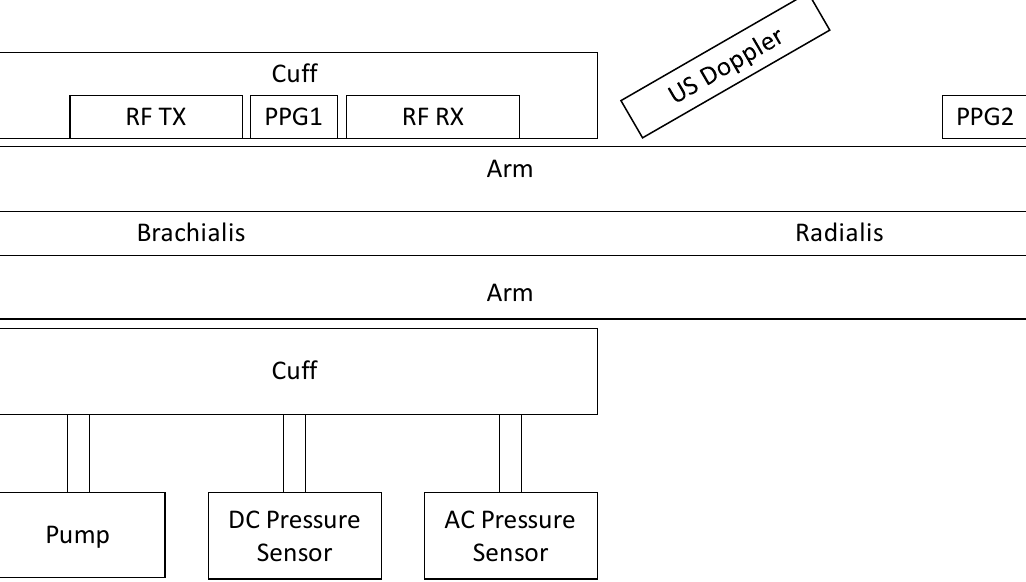
Figure 6. Complete measurement setup for blood pressure and pulse wave measurements for comparison and evaluation of ultrasonic, ultra-wide band radio frequency (RF) and optical signals.